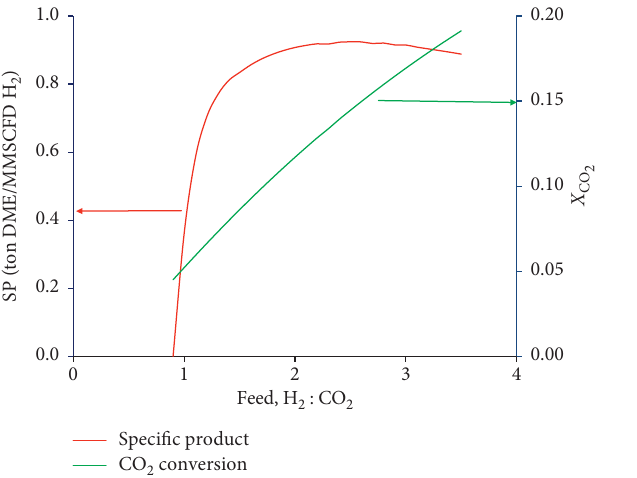
Figure 3: The effects of feed molar ratio of H product, SP, and CO 2 conversion, X